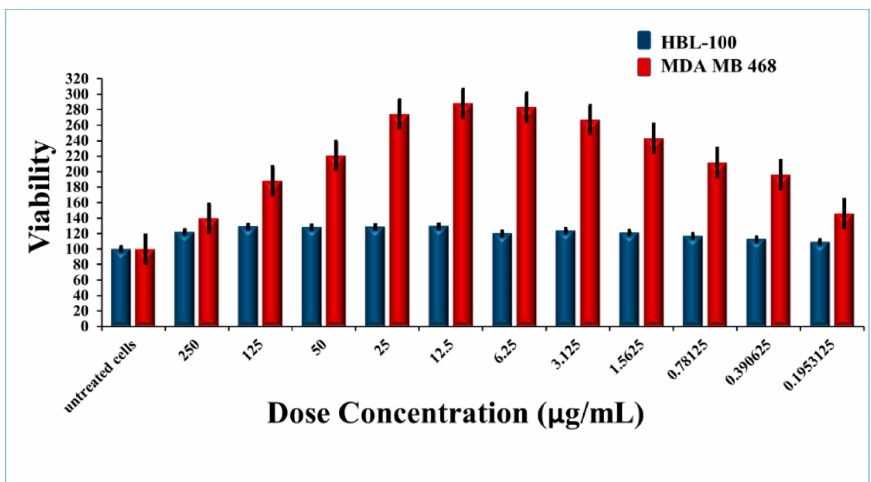
Figure 5. Cytotoxicity for RU-S4 against the human cell line.